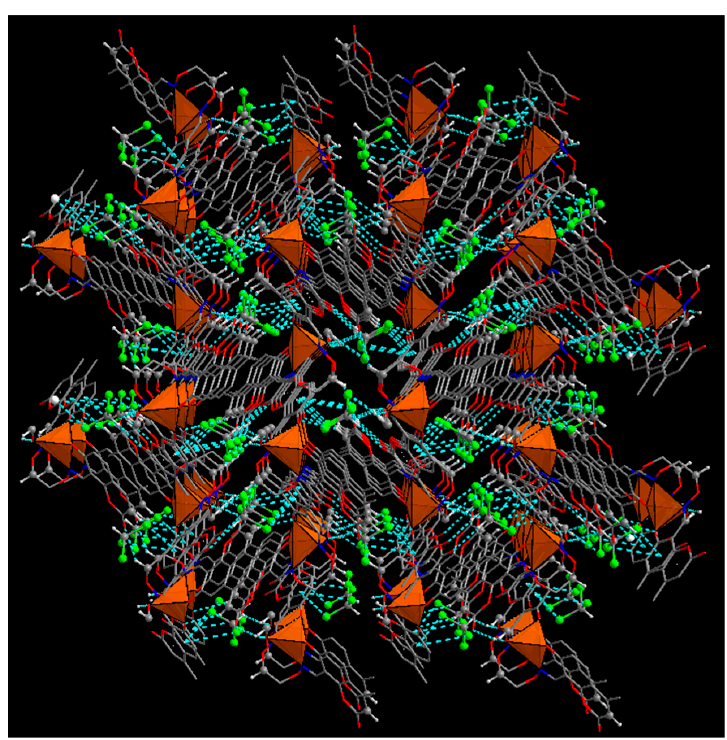
Figure 9. View of the three-dimensional supra-molecular structure of complex 2 exhibiting the C-H···O, O-H···O, C-H···Cl hydrogen bondings and C-Cl··· π stacking interactions. Table 7. Hydrogen bondings (Å, °) for complex 2 .